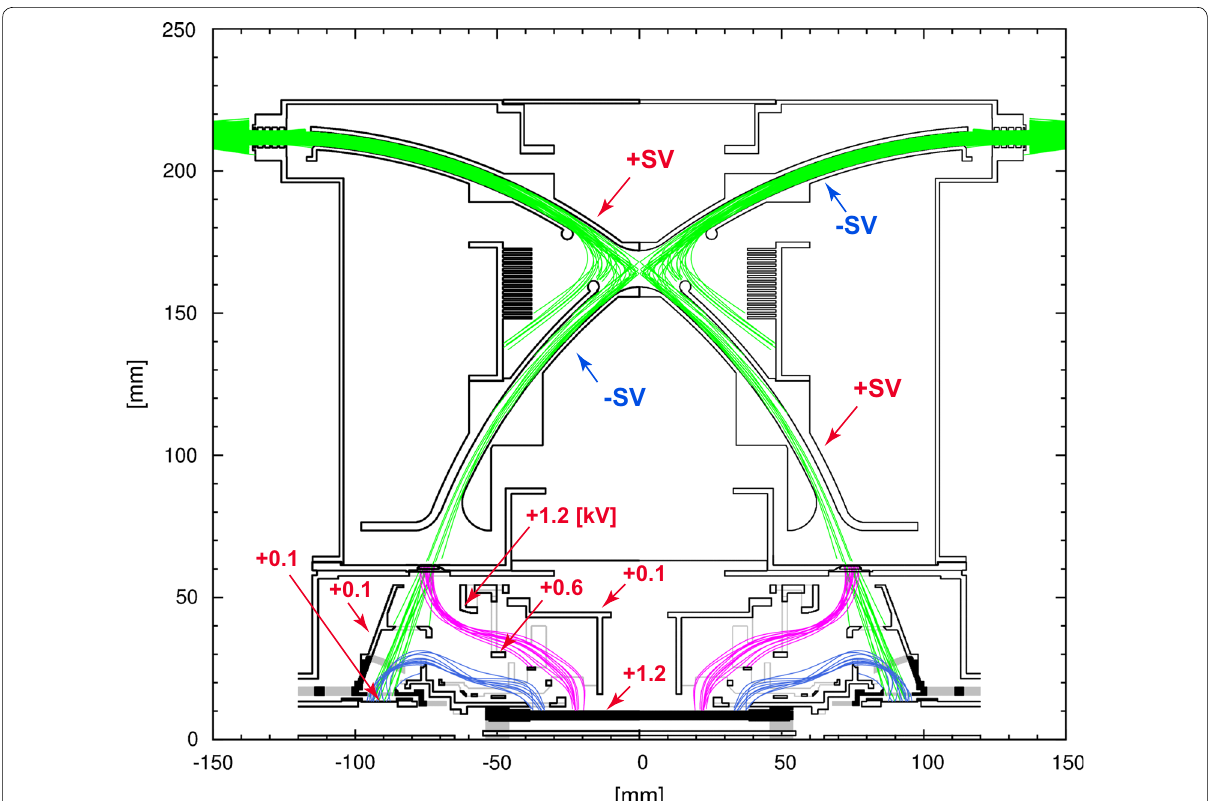
Fig. 4 Ion optics and trajectories of incident ions (green), and the start (purple), and stop electrons (blue) attracted to the MCP surface. All applied voltages are also